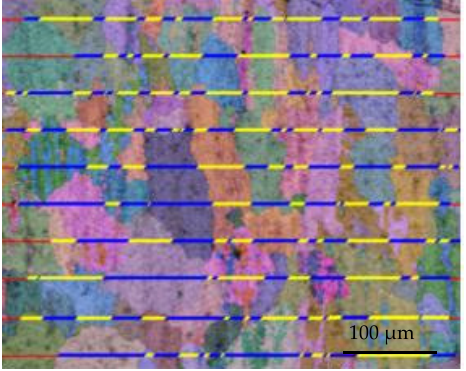
Figure 4. Grain size of Al-Mg alloyed additive measured by scribing method.